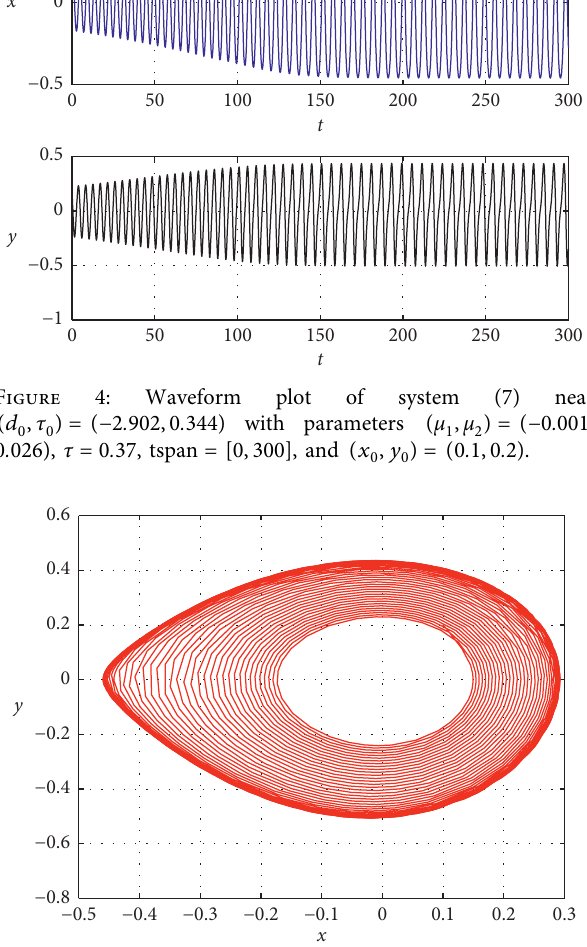
Phase portraits of system (7) near ( d , τ ) � (− 2 . 902 , 0 . 344 ) with parameters ( μ 0 0 0 . 026 ) , τ � 0 . 37, tspan � [ 0 , 300 ] , and ( x